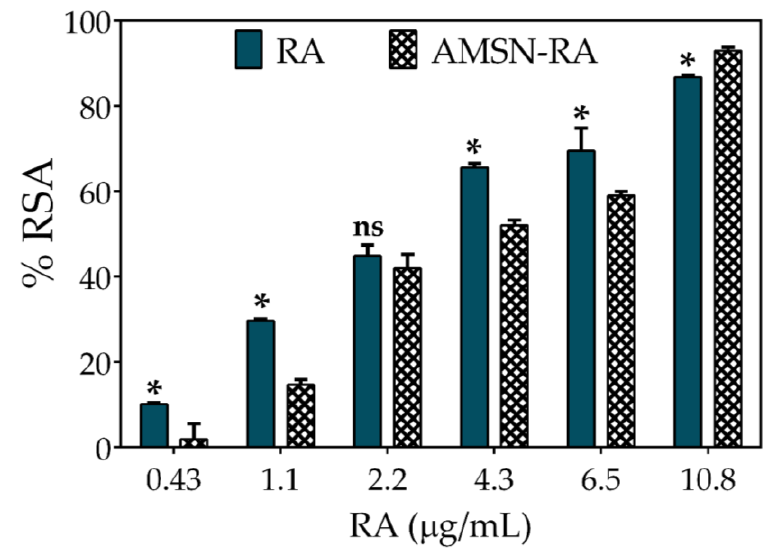
Figure 5. Antioxidant activity comparison between RA (rosmarinic acid standard) and nano-RA against DPPH • expressed as percentage of radical scavenging activity (%RSA) versus RA concentration. Results are reported as means ± SD ( n = 3). * p < 0.05; ns, not significant.